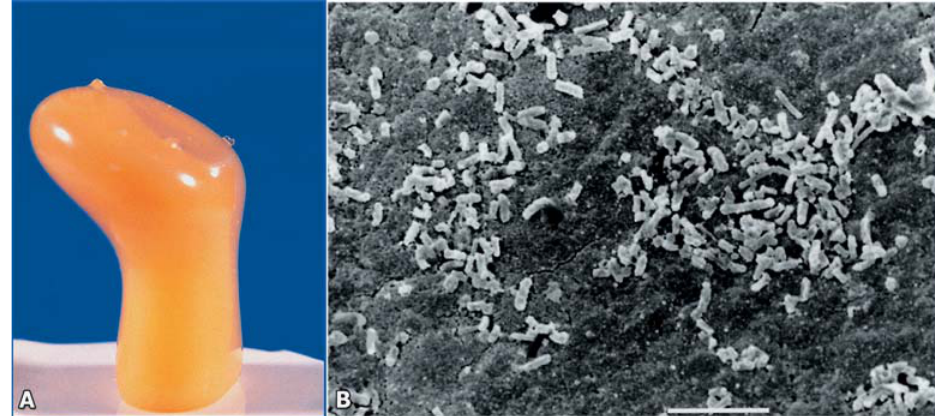
Figure 3- (cid:3)(cid:20)(cid:24)(cid:16)(cid:80)(cid:76)(cid:81)(cid:88)(cid:87)(cid:72)(cid:3)(cid:76)(cid:80)(cid:80)(cid:72)(cid:85)(cid:86)(cid:76)(cid:82)(cid:81)(cid:3)(cid:76)(cid:81)(cid:3)(cid:69)(cid:82)(cid:76)(cid:79)(cid:76)(cid:81)(cid:74)(cid:3)(cid:90)(cid:68)(cid:87)(cid:72)(cid:85)(cid:3)(cid:16)(cid:3)(cid:38)(cid:82)(cid:79)(cid:82)(cid:81)(cid:76)(cid:72)(cid:86)(cid:18)(cid:69)(cid:76)(cid:82)(cid:191)(cid:79)(cid:80)(cid:86)(cid:3)(cid:82)(cid:73)(cid:3) Mutans streptococci after microbial culture (A) and scanning electron microscopy micrograph (B)